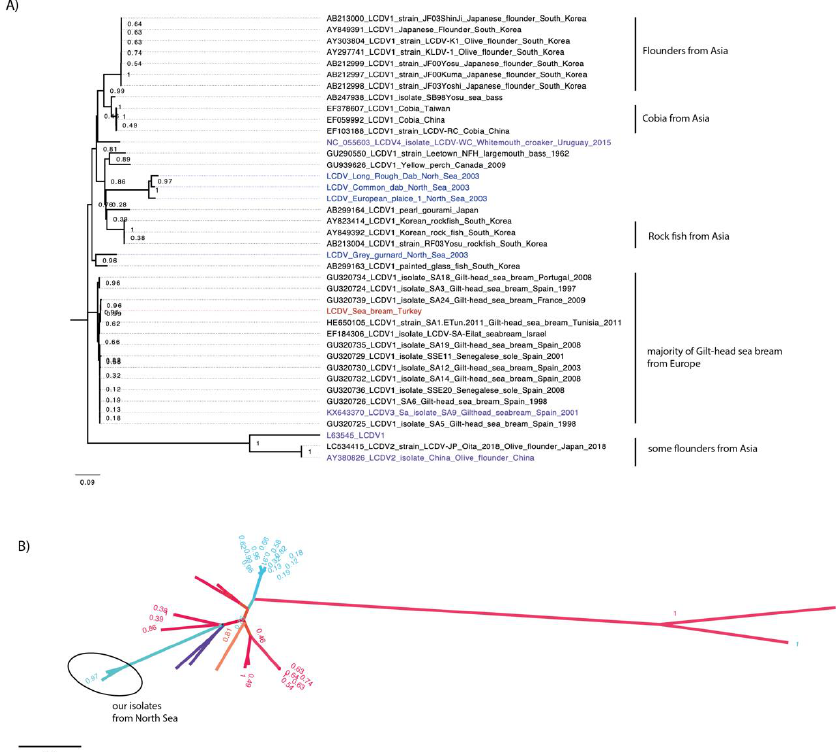
Figure 1. Phylogeny of the conserved MCP gene of LCDVs . Alignment of the new LCDV MCP gene sequences with other LCDV MCP gene sequences available from NCBI. Bootstrap values are indicated on tree branches. ( A ) LCDV1 to 4 are coloured in purple. MCP sequences from North Sea fish are coloured in blue and from Turkey in red. ( B ) Radial representation of the phylogenetic tree. Tree branches were coloured by locations. Viruses from Asia were colored in red, in blue from Europe, in orange from South America, and in purple from North America. The isolates of this study are encircled with a black line.